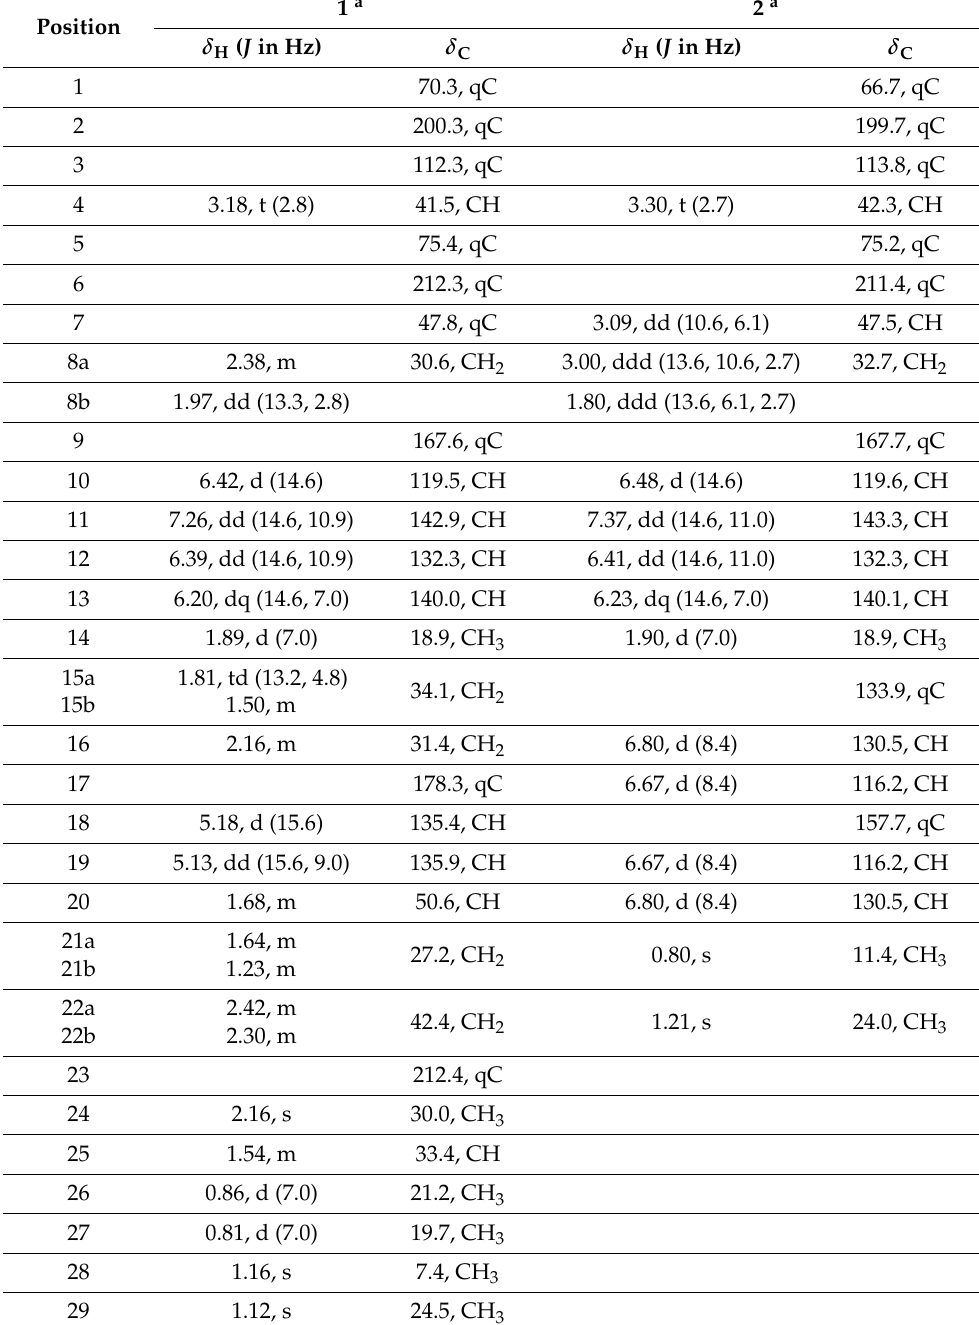
Table 1. 1 H NMR (500 MHz) and 13 C NMR data (125 MHz) for 1 and 2